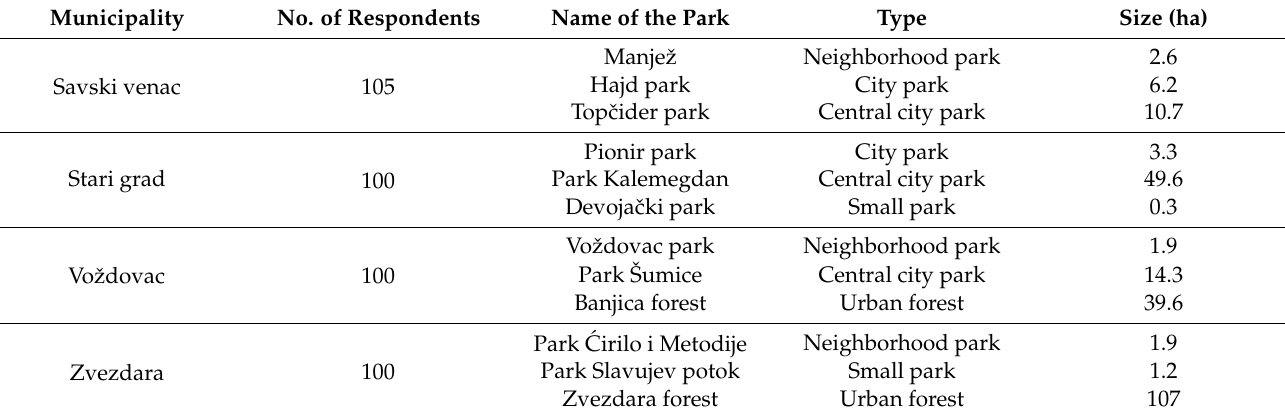
Figure 1. Study location and aerial photography of parks from 4 municipalities. Table 1. Study areas with main